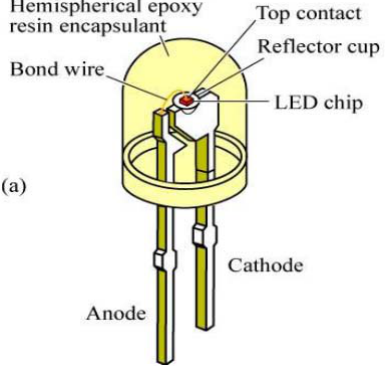
Figure 3. One of the LED types (after [1])